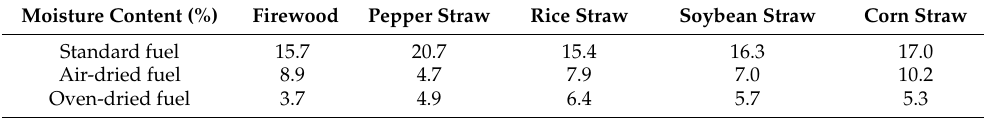
Table 1. Biomass moisture content * for standard biomass, air-dried biomass, and oven-dried biomass. Moisture Content